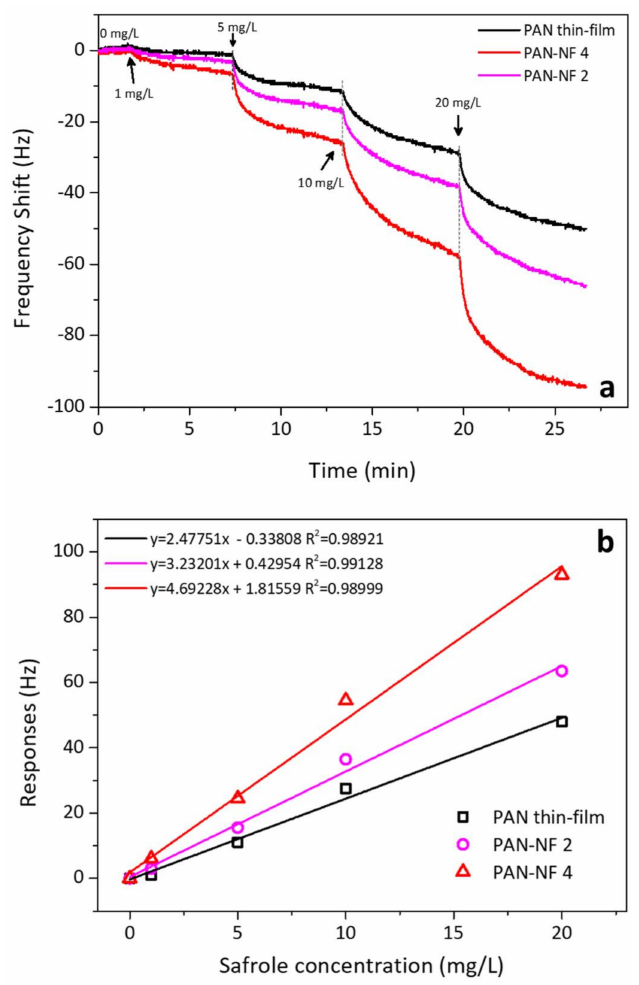
Figure 6. ( a ) QCM response to the various analyte concentrations; ( b ) QCM response after 5 min of contact with different analyte concentrations. The slope of the curve indicates the selectivity of the